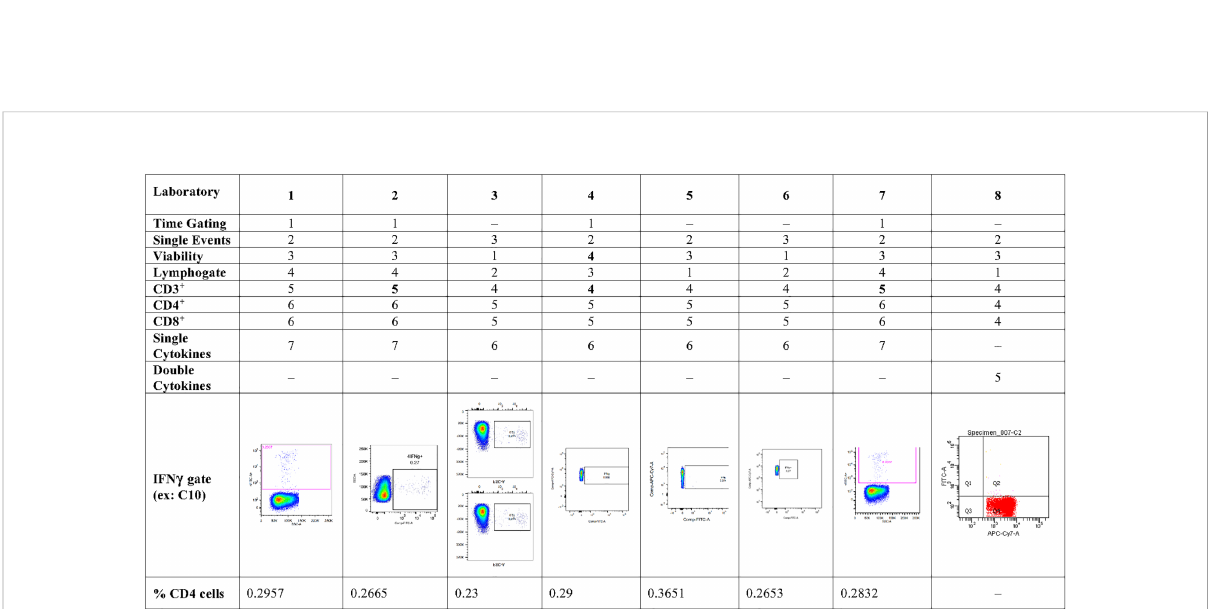
FIGURE 3 Pilot Study 2: Gating practices for cytokine secreting CD4 + T cells from each of the participating laboratories, and examples of a single cytokine gate (IFN g ) from each of the laboratories Eight laboratories participated in pilot study 2-, gating strategy did not show single IFN g -secreting cells; IFN,